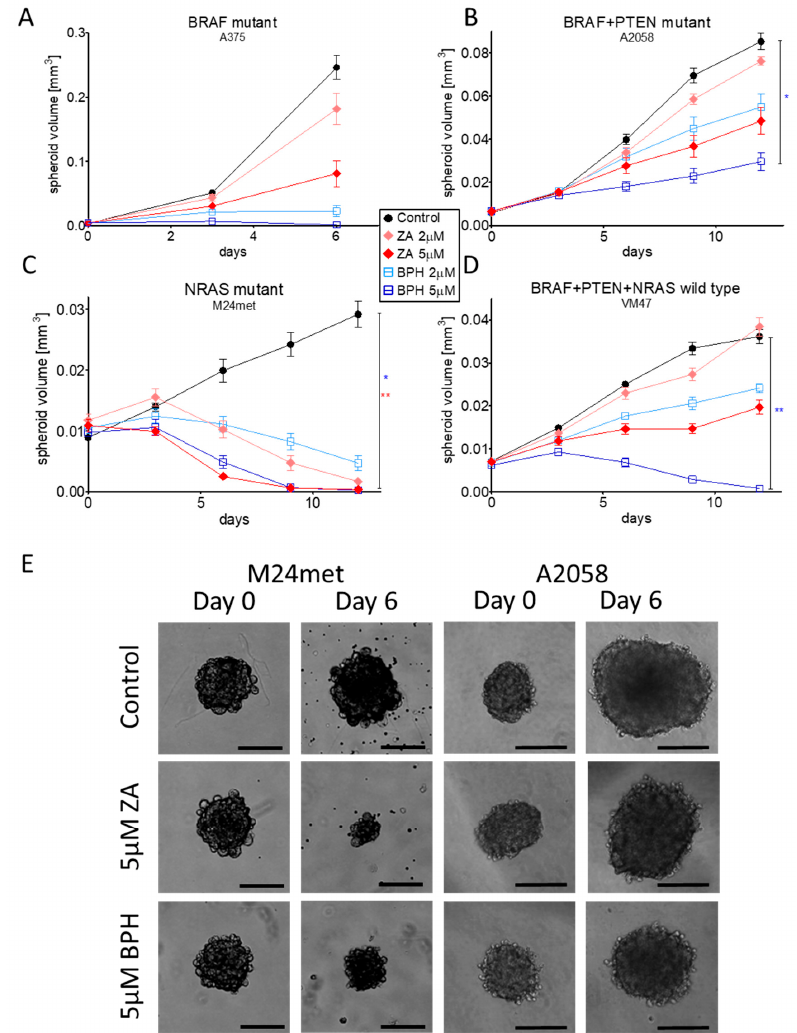
Figure 5. Three-dimensional spheroid growth experiment was performed to compare the effect of ZA and BPH. In the case of A375, A2058, and VM47 cell lines ( A , B , D ), BPH had a stronger effect compared to ZA, while the M24met cell line was more sensitive to ZA ( C ). Data are shown as the average ± SEM from at least two independent experiments. Asterisks mean a significant difference between the control and BPH (blue star) or ZA (red star) by * p < 0.05 and ** p < 0.01. ( E ) Representative pictures show the effect of the inhibitors on the sixth day after treatment with 5- μ M ZA or BPH. Scale bar means 200 μ m.